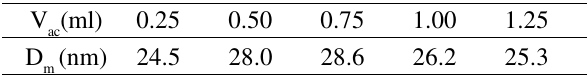
Table 1. Average Fe particles sizes D alloy in different nitric acid concentrations V